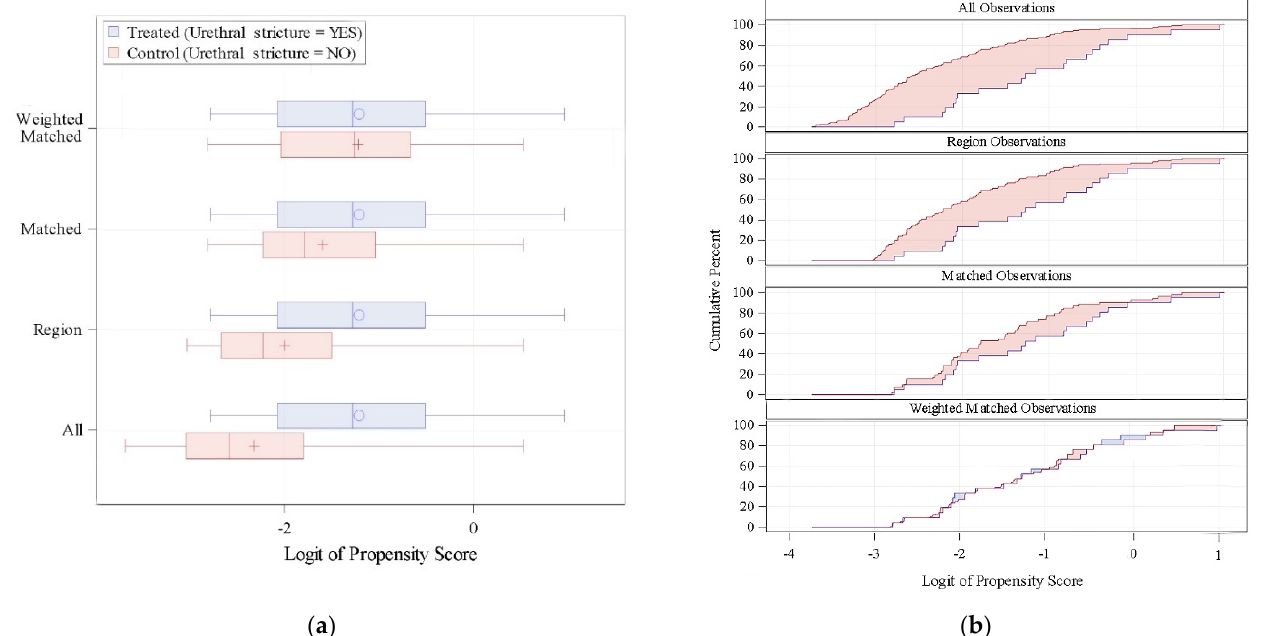
Figure 2. ( a ) Distribution of the Logit of Propensity Scores (LPS). ( b ) Cumulative distribution of the LPS.